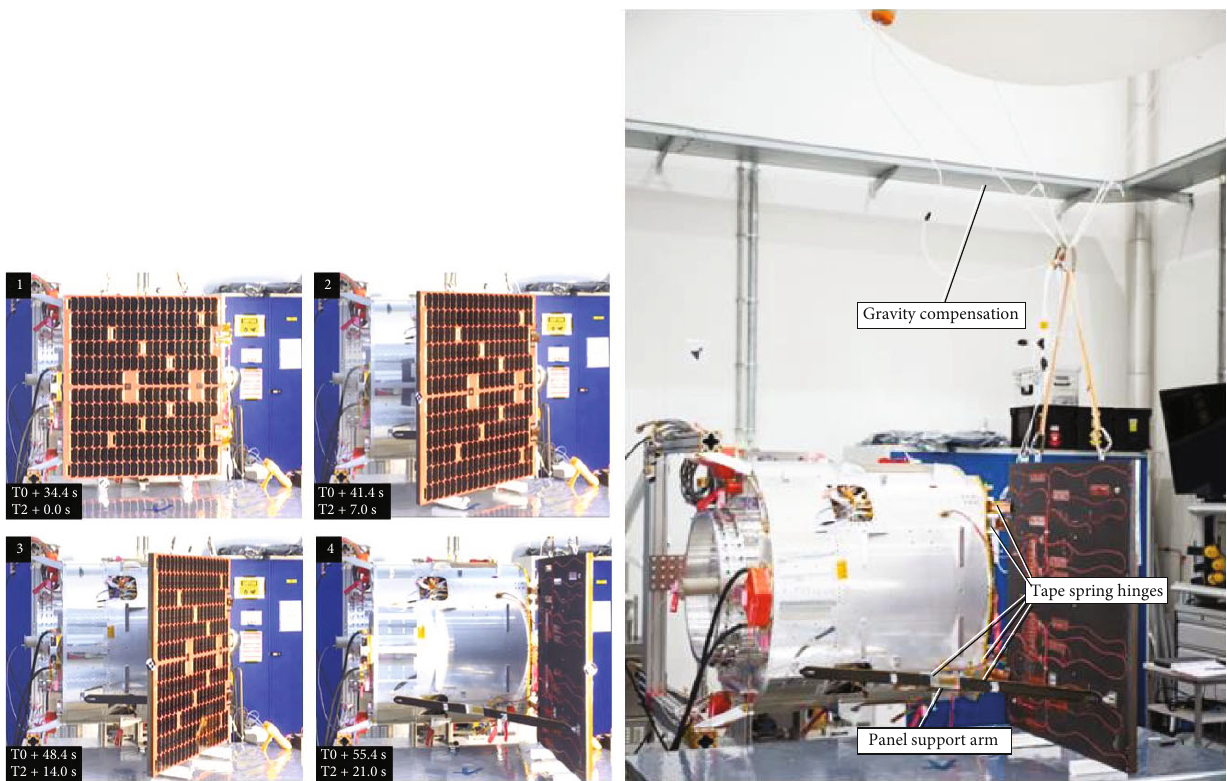
Figure 19: Panel deployment and